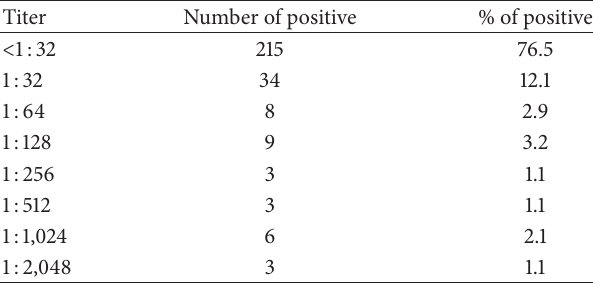
Table 2: Toxoplasma gondii antibody titers, by latex agglutination test (cut-off ≥ 64) in 281 goat sera in